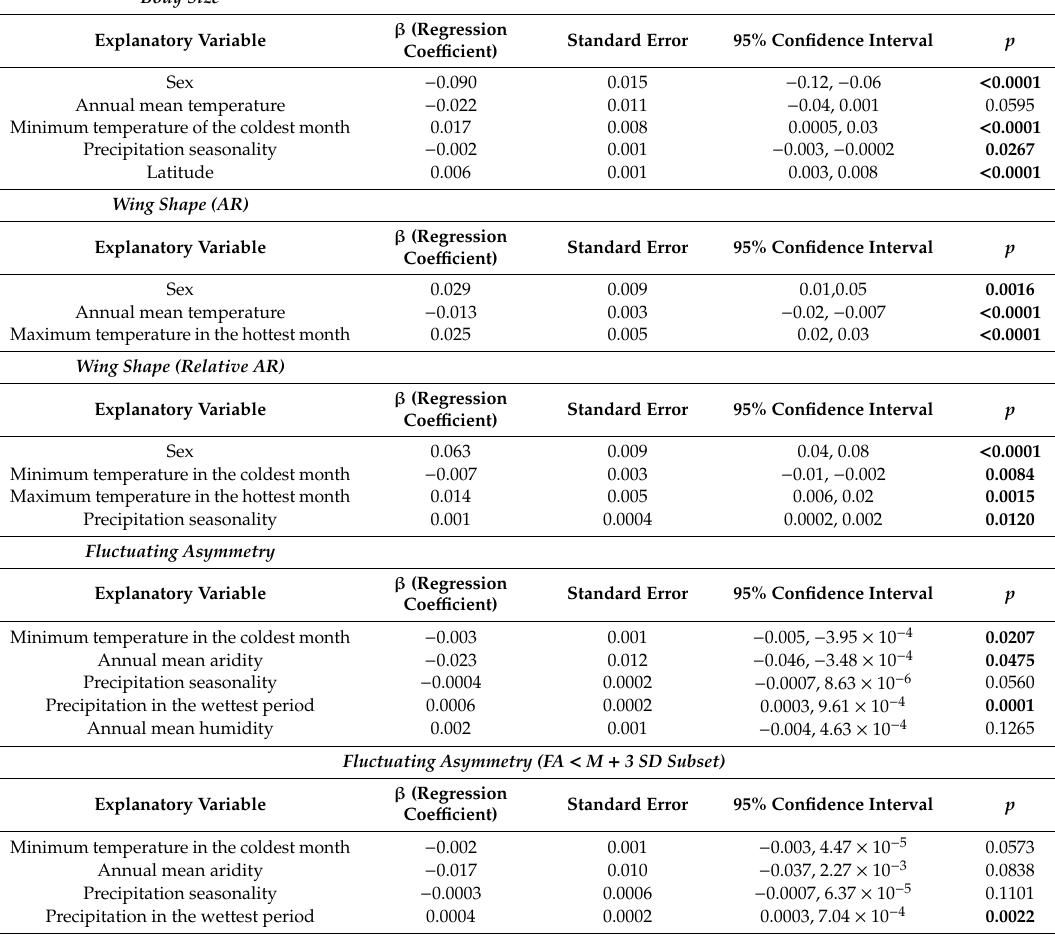
Table 2. Generalized linear model (Gaussian distribution) regression of relationships between Q-fly traits and environmental variables. Significant relationships between traits and variables are highlighted in